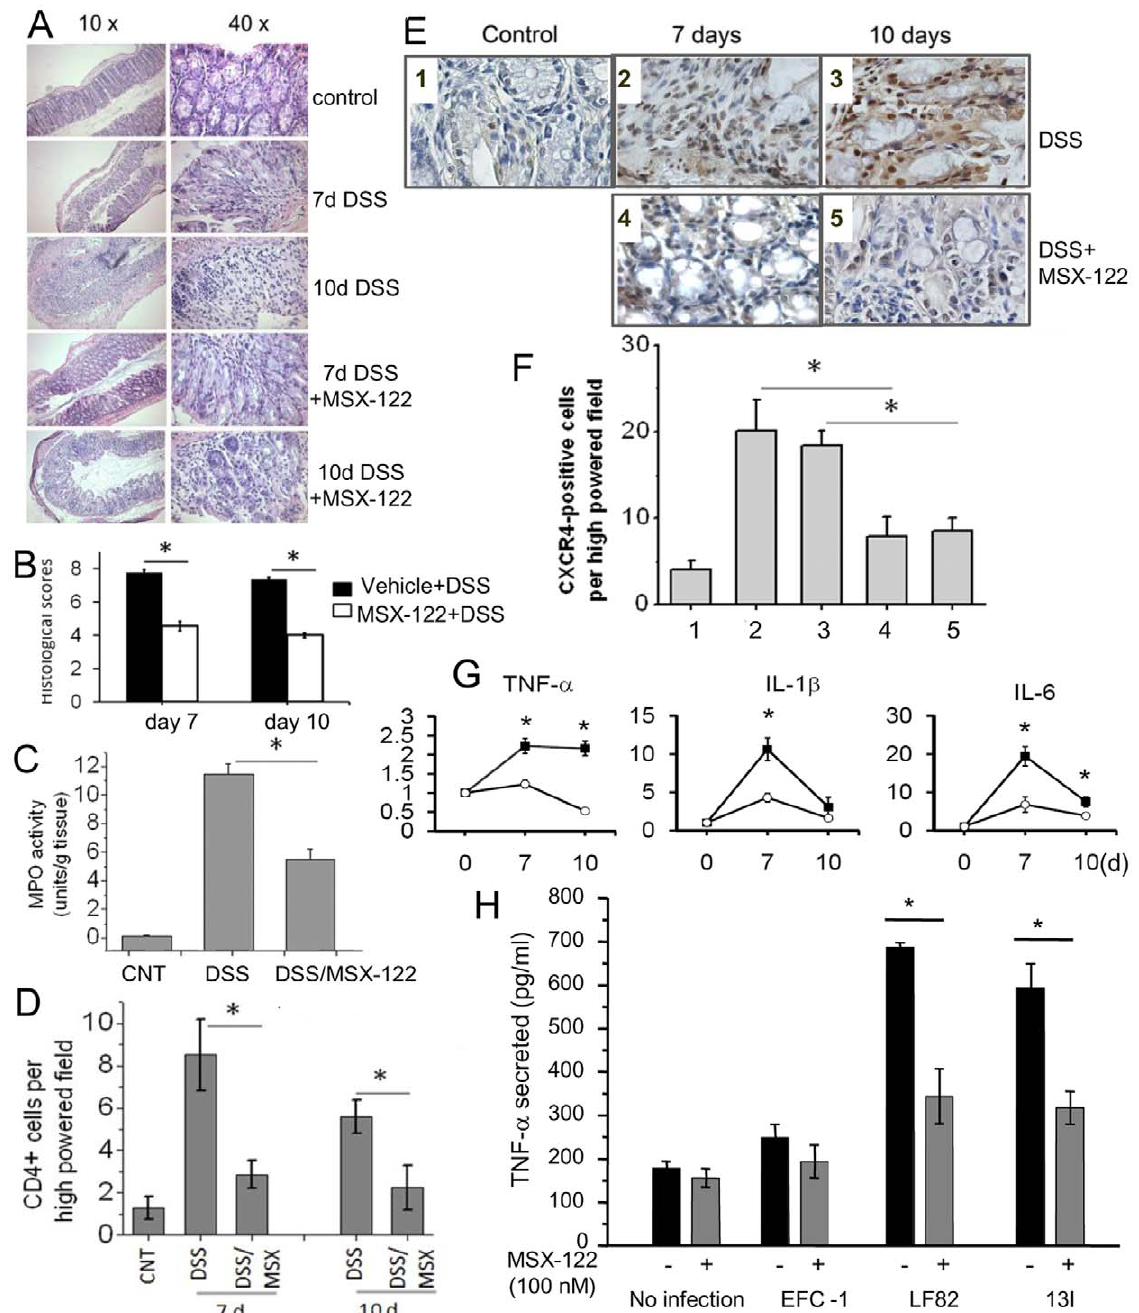
Figure 4. MSX-122 attenuates colonic damage in mice with experimental colitis. (A) Colonic sections were stained with H&E. (B) Histological scores were determined by a blinded examination of the sections. n=16 per group. *, p , 0.05 between DSS and DSS + MSX-122 treated mice. (C) MPO activity was measured in the colons of control, DSS-, and DSS/MSX-122-treated mice. MPO activity was expressed as unit of MPO per mg colonic lysate. n=12. *, p , 0.05. (D) The presence of CD4 + lymphocytes was detemined by immunohistochemically using anti-CD4 antibodies. CD4 + lymphocytes are depicted in the brown color and nuclei were counter-stained in the blue color. Quantification of CD4 + lymphocyte per high powered field is shown. n=4–5. *, p , 0.01. (E) Representatives of immnohistological staining of CXCR4-positive cells are shown. CXCR4 protein is depicted by the brown color, whereas nuclei were counter-stained in blue. 1, control; 2, 7 days DSS; 3, 7 days DSS + 3 days or recovery; 4, 7 days DSS/ MSX-122; and 5, 7 days DSS/MSX-122 + 3 days MSX-122. (F) Quantitative analysis of CXCR4-positive immune cells in the colon is shown. *, p , 0.01. MSX-122 blocks migration of CXCR4 positive cells. (G) Expression of cytokine mRNAs was determined by qRT-PCR. Expression levels of cytokines were normalized to 18S. n=8. *, p , 0.05. (H) MSX-122 attenuates TNF- a secretion induced by invasive E.coli . J774A.1 macrophages in triplicates were infected with overnight cultures of commensal E.coli EFC-1, CD-isolated E.coli LF82 or 13I at MOI 10:1 for 3 h. Following 3 h infection, macrophage culture was washed and incubated for additional 21 h in a growth medium containing antibiotics and MSX-122. The amounts of TNF- a in the supernatant were quantified by ELISA. Representative data from three independent experiments, each performed in triplicate, are shown. *, p , 0.05.